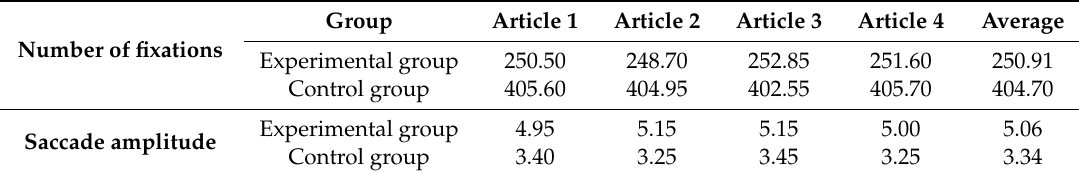
Figure 10. Statistical comparison of the number of fixations and saccade amplitude on four Japanese reading articles for the two groups: ( a ) number of fixations; and ( b ) saccade amplitude. Table 4. Number of fixations and saccade amplitude for the two groups.